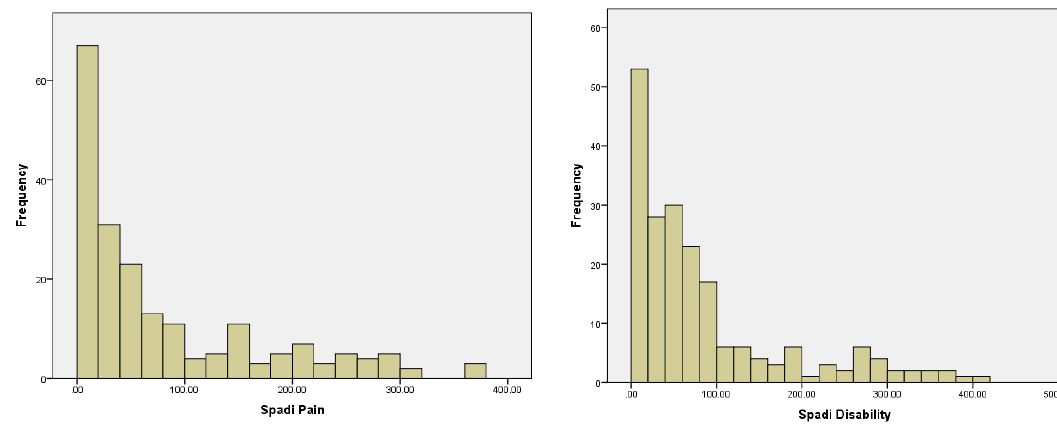
Figure 1. Frequency distribution for pain and disability ( N = 202).